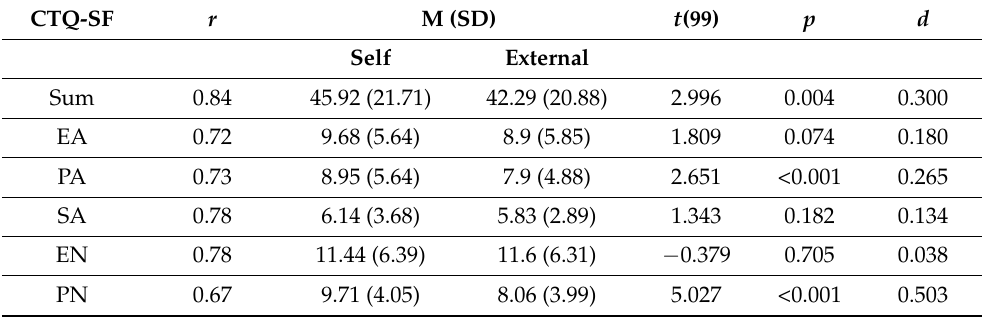
Table 5. Mean Differences between CTQ Self-Assessment and External Assessment within the Risk Assessment